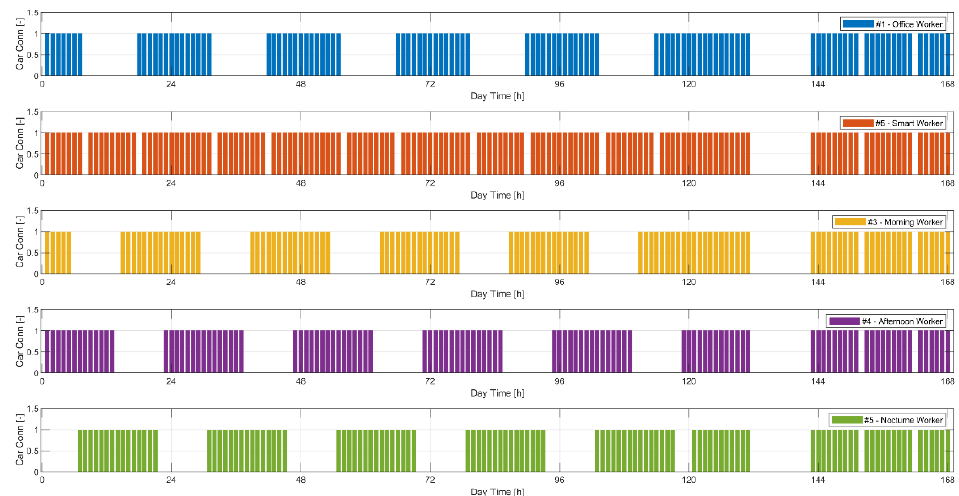
Figure 3. Weekly connection time of the electric vehicle to the home recharging equipment for the different end users.